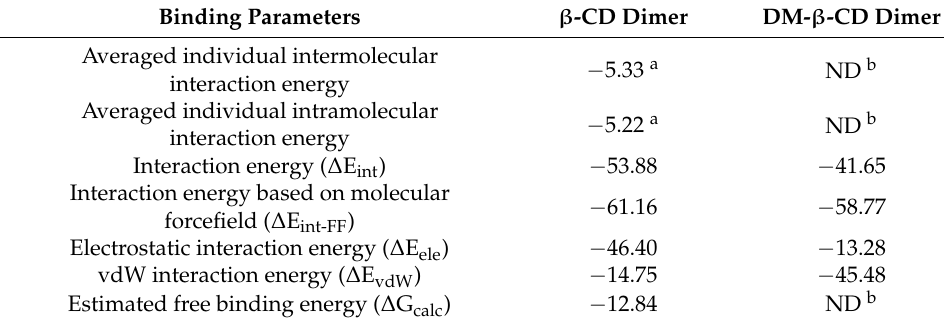
Table 3. Binding parameters for the host-host dimers of β -CD and DM- β -CD in kcal/mol. Binding